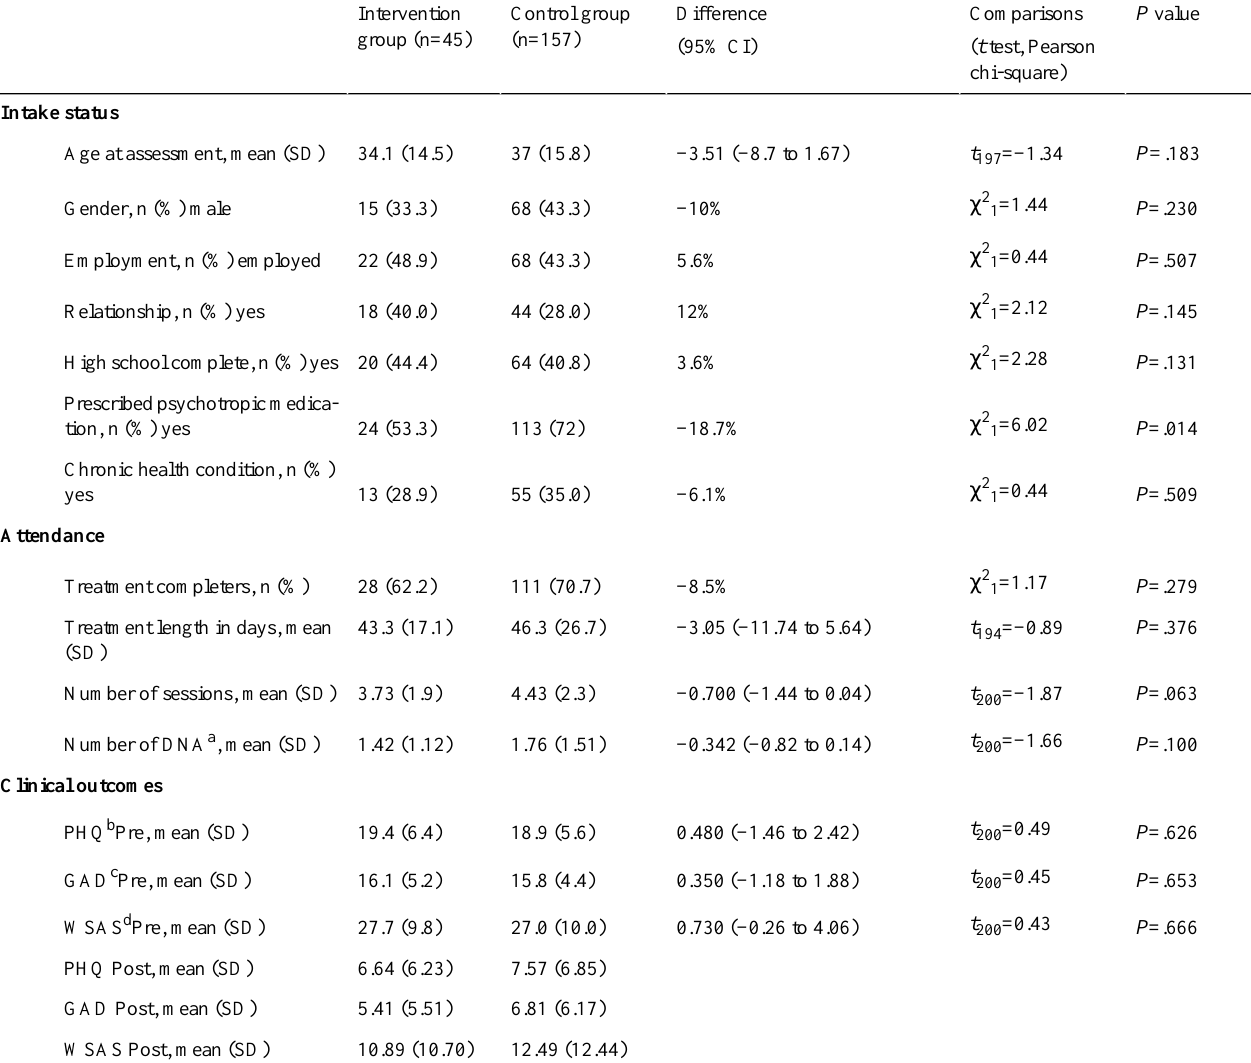
Table 1. Intake status, attendance, and clinical outcomes for the intervention and control